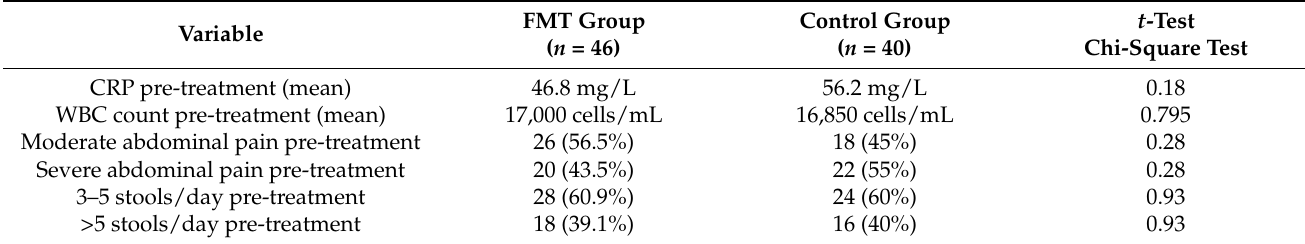
Table 2. Clinical manifestations and inflammatory status prior to treatment.